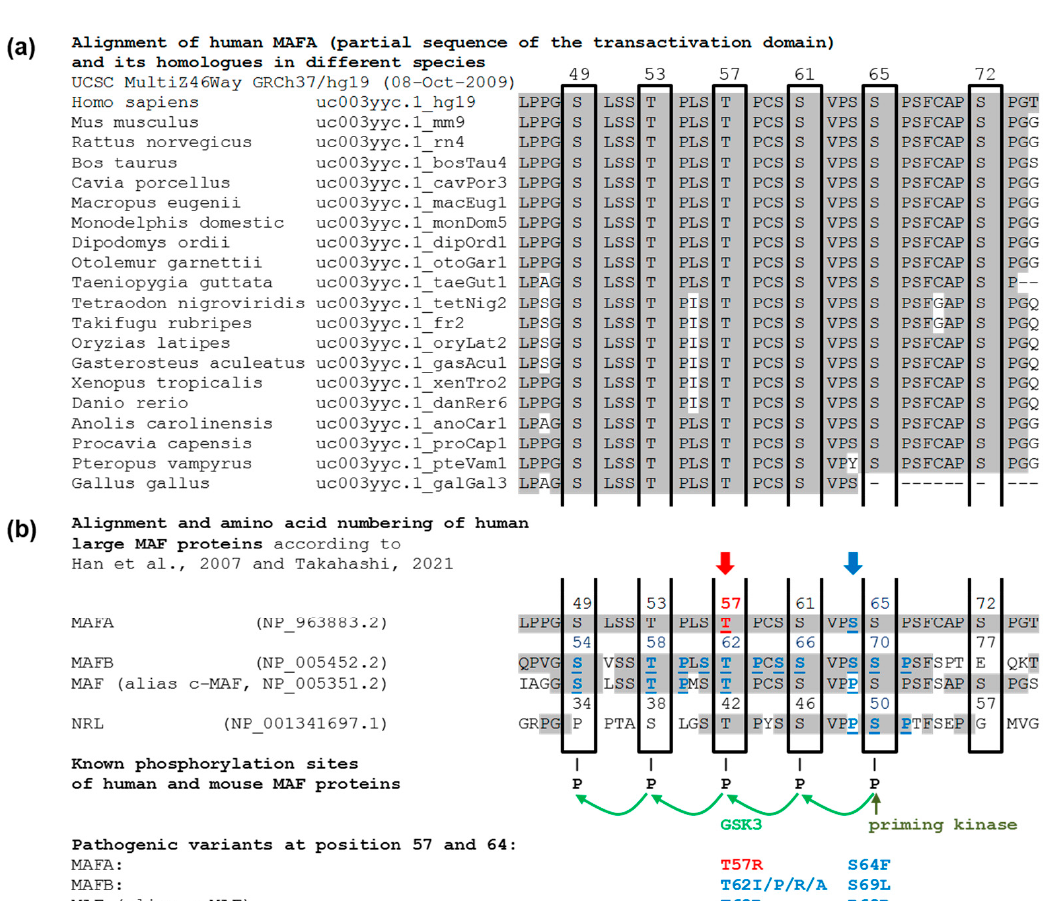
Figure 6. D/E/S/T/P-rich region of the MAFA transactivation domain ( a ) illustrates high conservation of a functionally essential part of the MAFA transactivation domain known to regulate MAFA binding to its target DNA sequences by phosphorylation. Conserved amino acid residues are shaded gray, and black frames indicate the phosphorylation sites. The numbering refers to human MAFA. ( b ) shows the high homology of this region among the members of the large MAF transcription factor family in humans and illustrates the GSK3-mediated phosphorylation cascade, which is initiated by the phosphorylation of residue 65 (MAFA) by a priming kinase (21, 23). Amino acid residues known to be affected by pathogenic variants are provided in blue and underlined, and the MAFA variant Ser64Phe is among them (blue arrow, S64F), which has been shown to cause a phosphorylation defect and a syndrome characterized by insulinomatosis, mild diabetes, and cataract (12). The red arrow marks the amino acid affected by the MAFA variant Thr57Arg (T57R) reported in this manuscript. In vitro transfection studies (23) have confirmed that the exchange of MAFA residues 65, 61, 57, 53, and/or 49 by alanine, an amino acid which cannot be phosphorylated, causes phosphorylation defects and impairs MAFA-binding to DNA. For two further large MAF proteins (MAFB and c-MAF), pathogenic missense variants have already been detected and among them include the MAFB variants Thr62Arg (21) and Thr62Ala (ClinVar VCV000807627.3, T62I/P/R/A) and the MAF (c-MAF) variant Thr62Arg (T62R) (24), variants with the same amino acid exchange as we now found in MAFA.